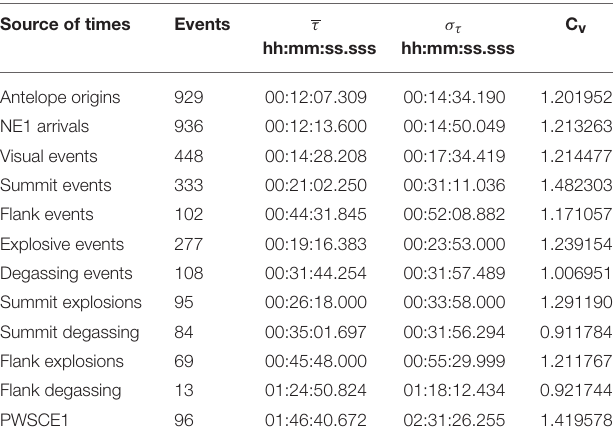
TABLE 1 | The mean, standard deviation, and coefficient of variation of the lengths of inter-event times. Source of